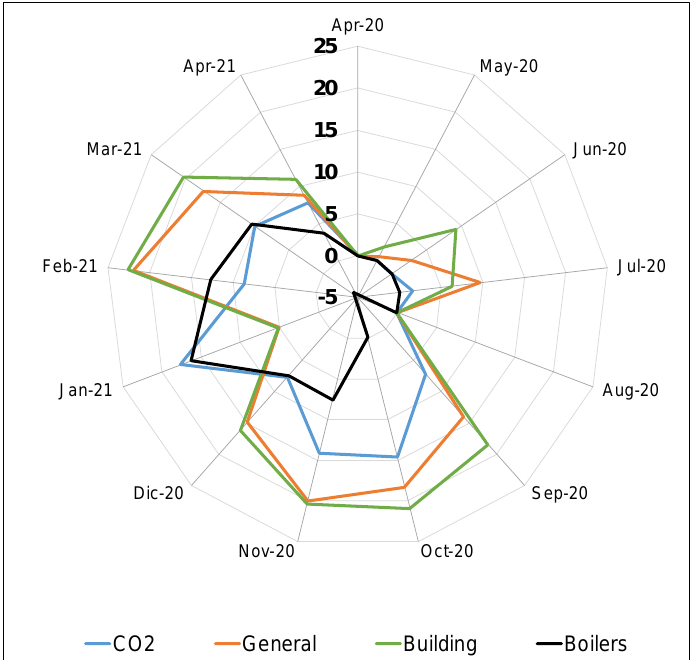
Figure 7. Monthly deviation in percentage of classroom occupancy hours: estimated vs. theoretical for the CO 2 concentration indicator and electricity consumption indicators.